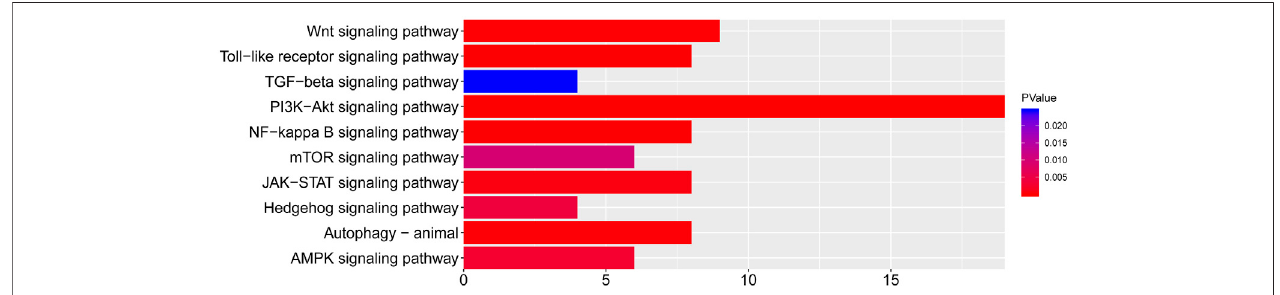
FIGURE 3 | The top 10 pathways for the KEGG pathway are enriched from the common targets between JPYSF and epithelial – mesenchymal transition (EMT).